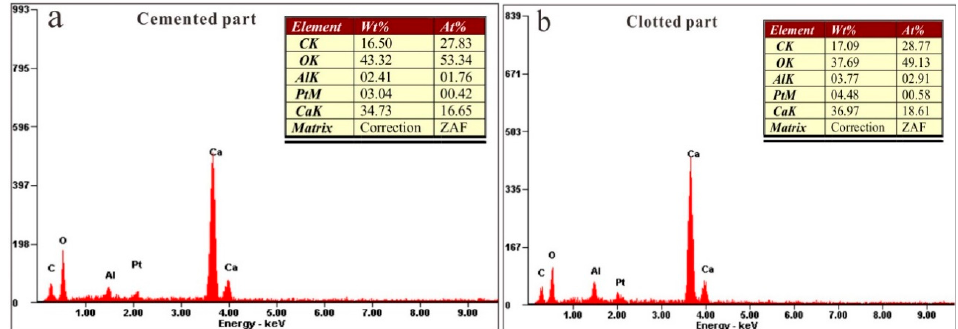
Figure 4. ( a ) The elemental compositions of the cemented part; ( b ) the elemental compositions of the